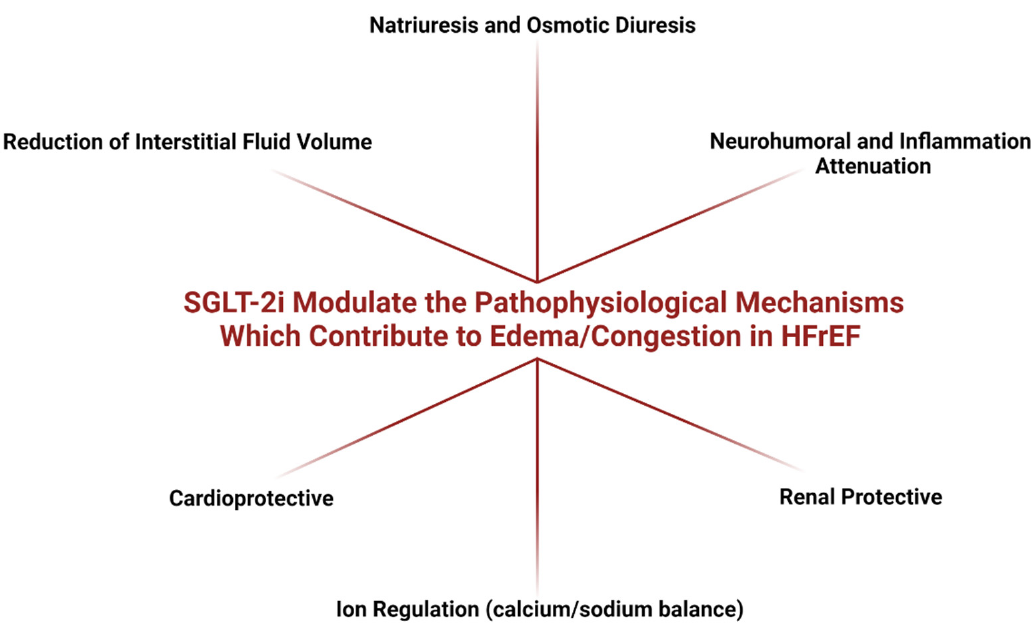
Figure 1. Summary of Mechanisms Contributing to Outcomes of SGLT-2i on Edema/Congestion in HFrEF [15–17,37–48,68,69].